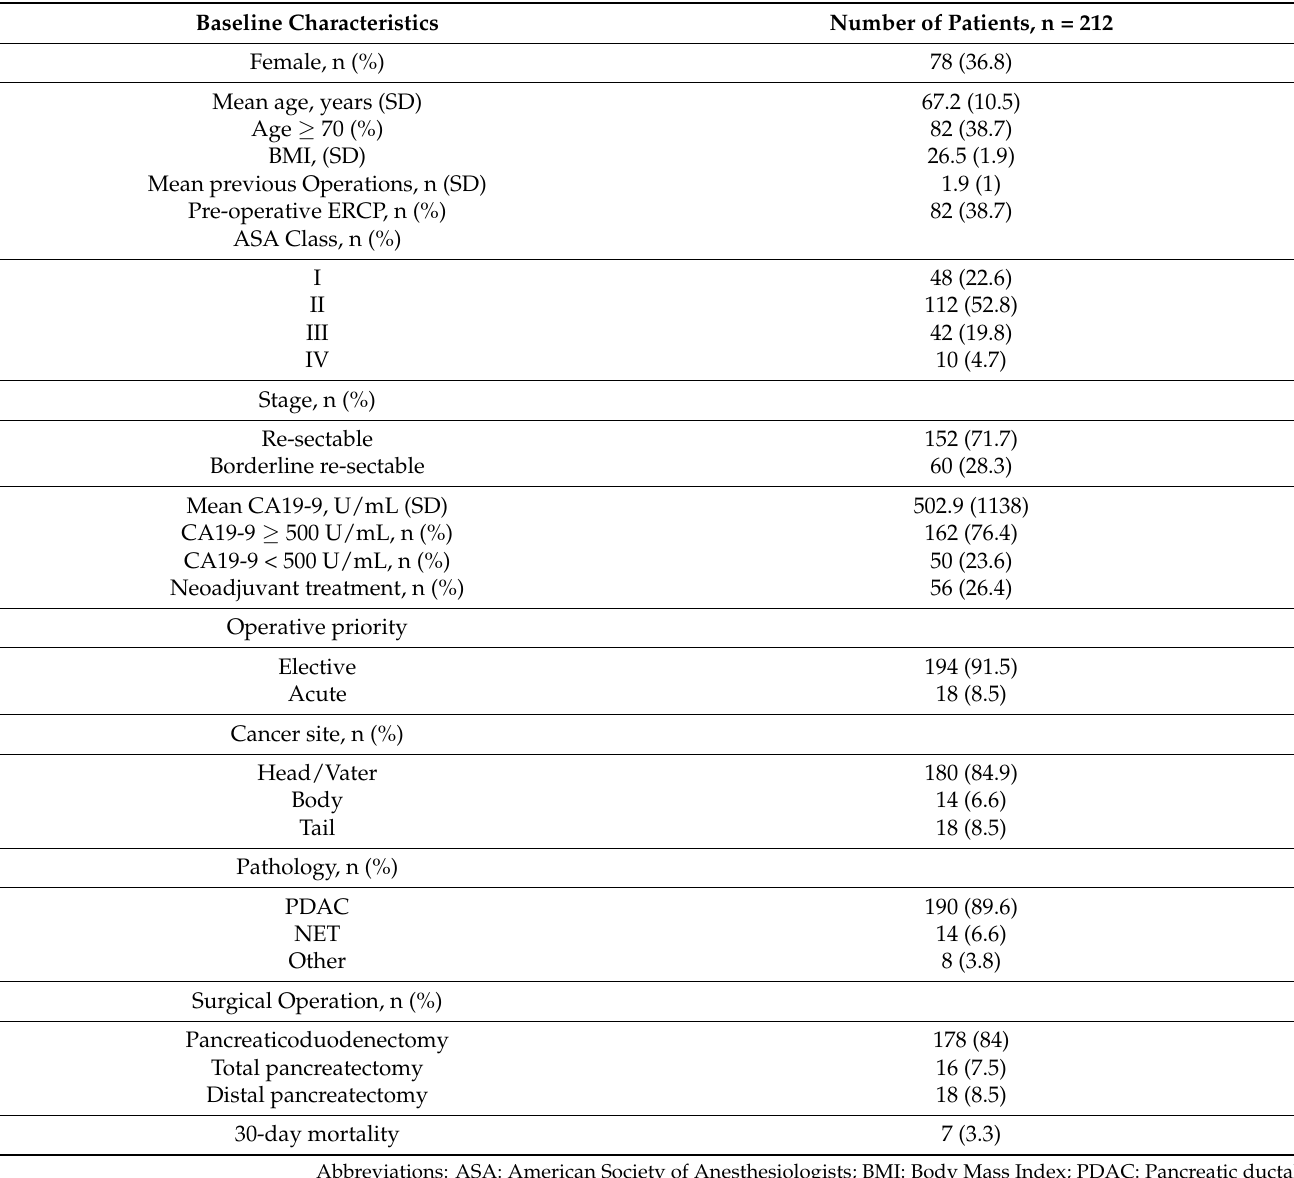
Table 1. Patient baseline characteristics.